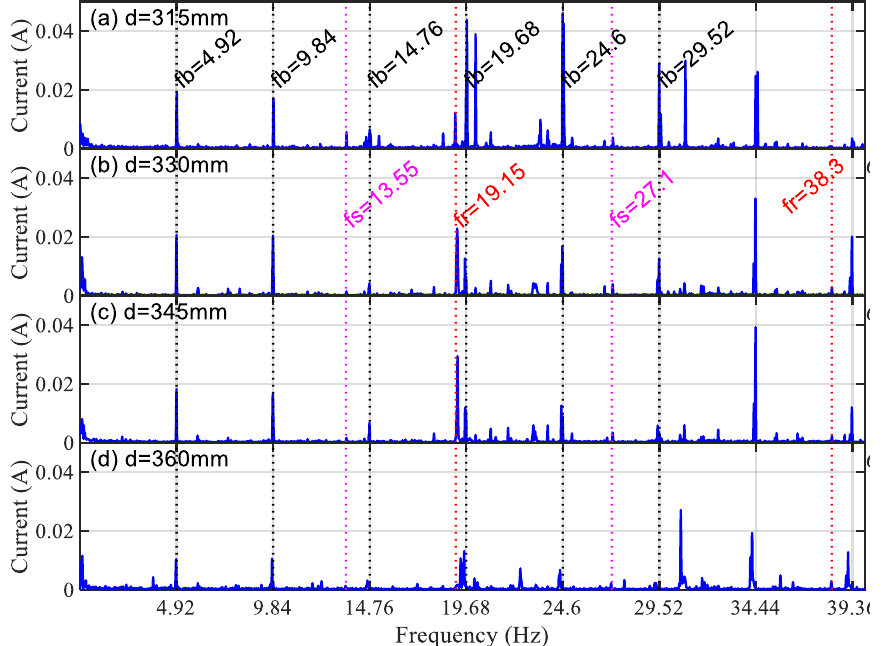
Figure 16. Envelop result of current signal with different tensioning conditions.